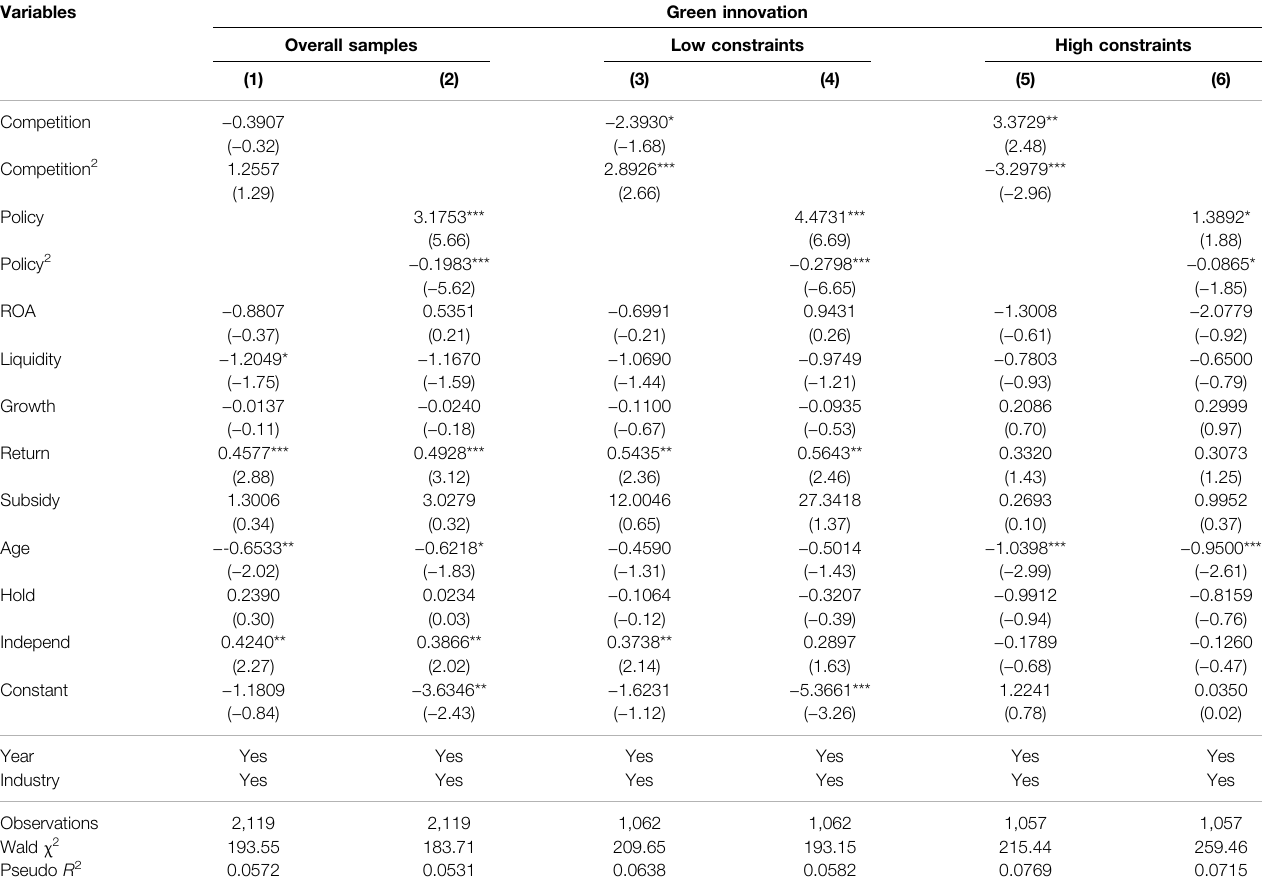
TABLE 8 | Results of nonlinear